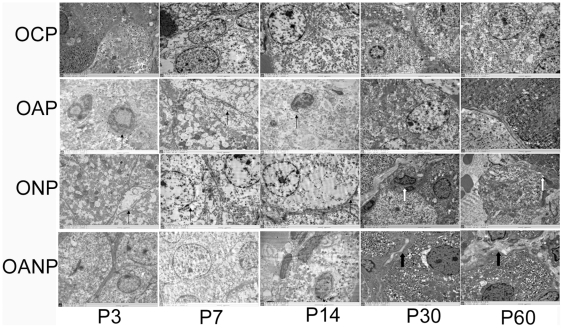
Electron micrograph of adrenal medulla in offspring rat.The adrenal medulla cells of OAP and ONP rats showed edema of cytoplasm
and mitochondrial, vacuolar degeneration, deceased EPI secretory
granule. chromaffin cells appeared fiber outgrowth and changed into
spindle shape with long fusiform nucleus from P3 to P14(thin arrow).
From P30 to P60, vacuolar degeneration showed decreased and the PEI
secretory granule become increasing. At the same time, nerve fibers of
ONP rats were rich in density, myelinated and unmyelinated nerve fibers
can be seen (hollow arrow). There were mitochondrial edema and decreased
chromaffin with enriched EPI granules in OANP rats. More collagen
emerged and divided adrenal medulla into island from P30 to P60 (thick
arrow). (The magnification of the image is 10000 ×).